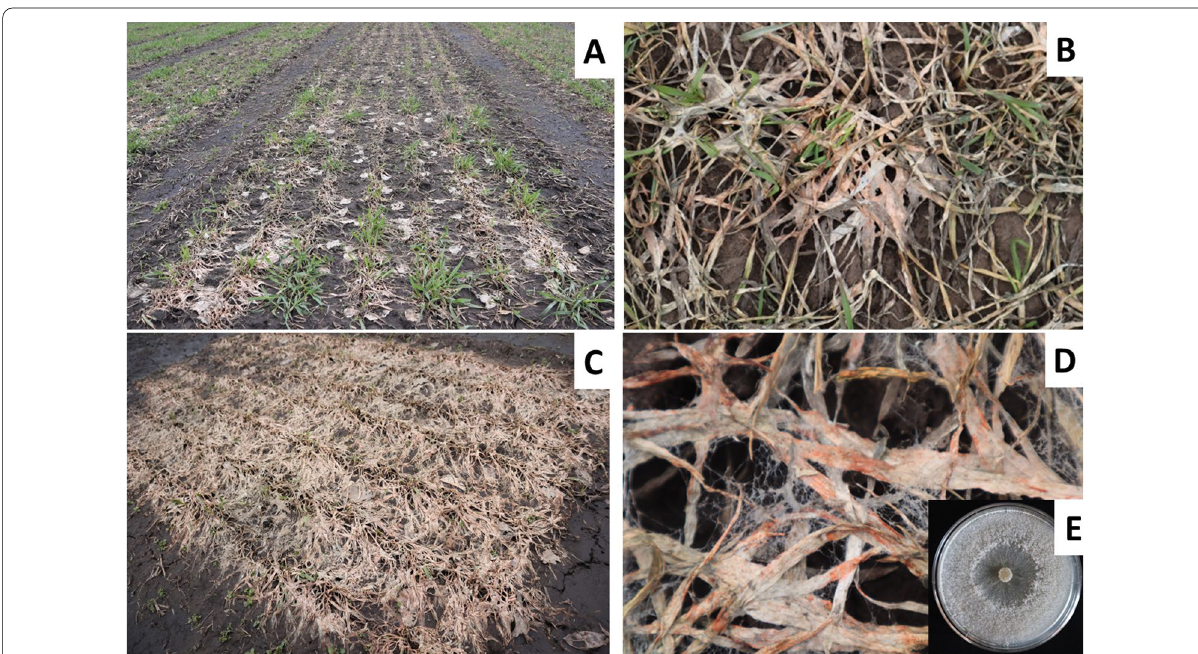
Fig. 1 Pink snow mold caused by Microdochium nivale on winter rye. Photos were taken on 26.04.2021, ten days after snow melt, in the fields